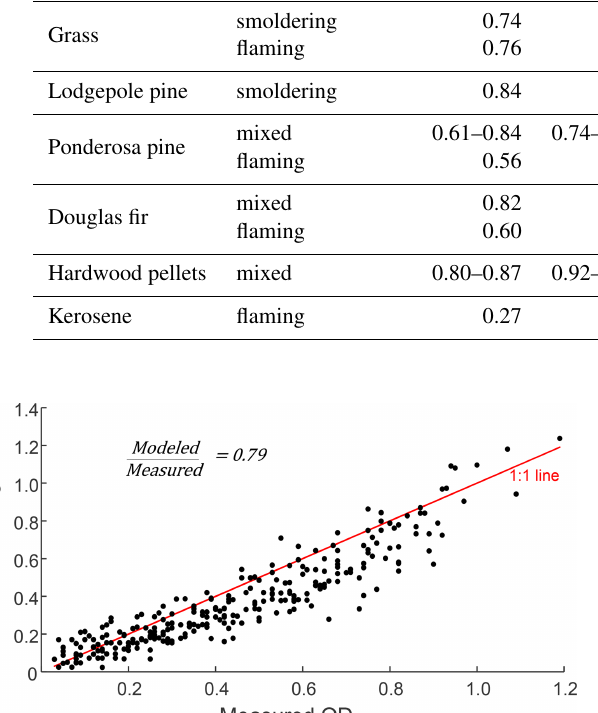
Figure 6. Relationship between in situ aerosol optical depth ( τ a , s ) and filter optical depth OD s for all ( n = 90) samples, measured at 375, 405, and 532nm ( N = 270 data points). The best fit curve is given by Eq. (10), with R 2 = 0 . 87. The black perforated line has a fixed slope of 0.67 per Zhong and Jang (2011). Uncertainties (1 SD) in OD s ranged 2–5%, while those in τ a , s were